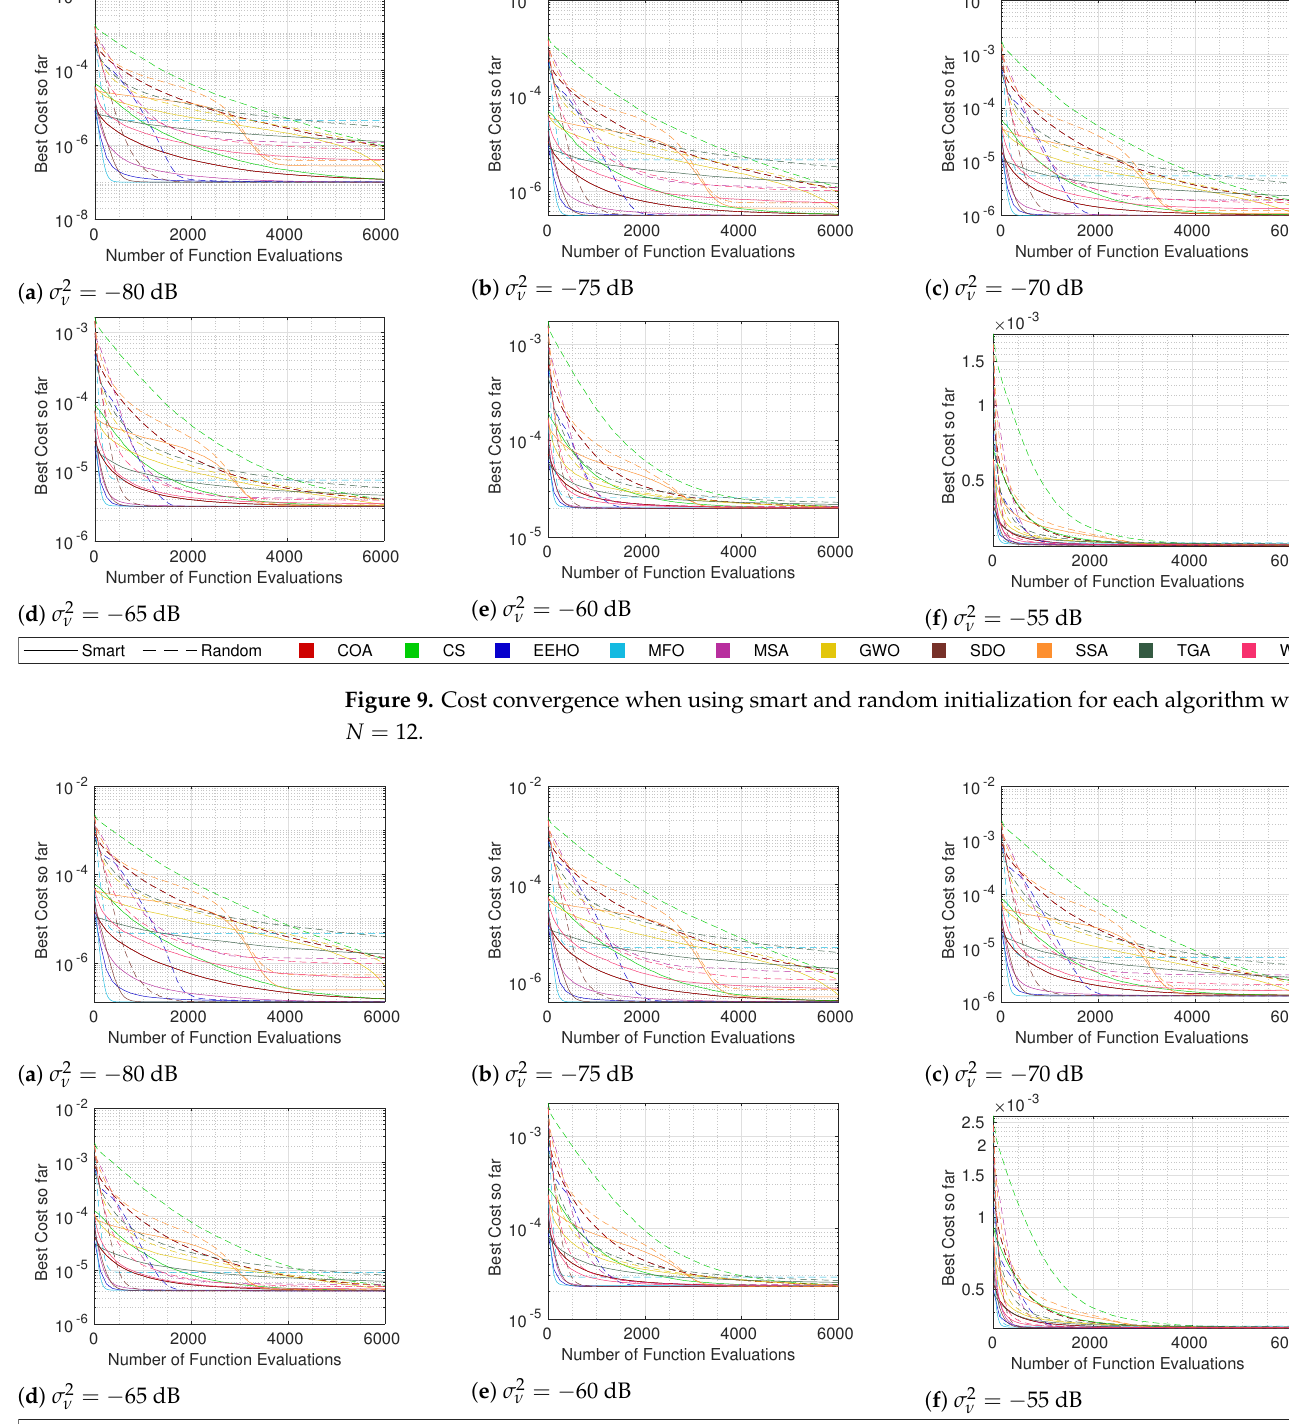
Figure 10. Cost convergence when using smart and random initialization for each algorithm when N =